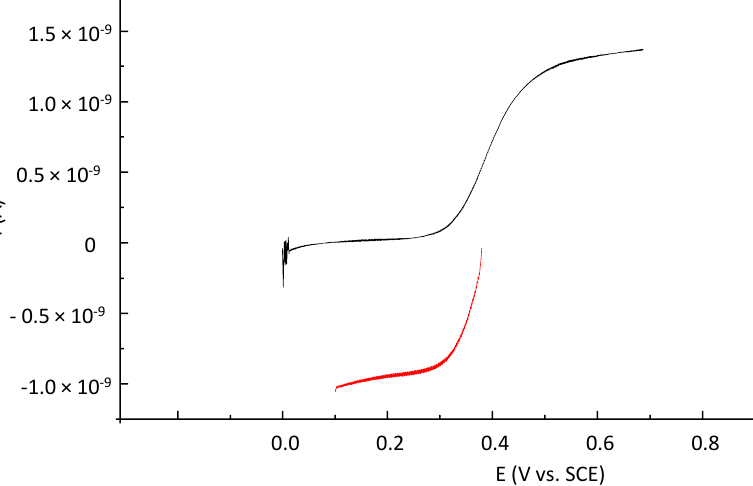
Figure 4. Stationary voltammograms of P797 (0.5 mmol.dm − 3 ) in acetonitrile + TBABF 4 0.1 mol.dm − 3 at a 25 µ m Pt disk ultramicroelectrode. Scan rate: 0.05 V.s − 1 . Black curve: anodic scan of P797 before electrolysis. Red curve: cathodic scan recorded after a 0.92 Faraday/mole electrolysis at a gold grid anode polarized at 0.7 V/SCE.